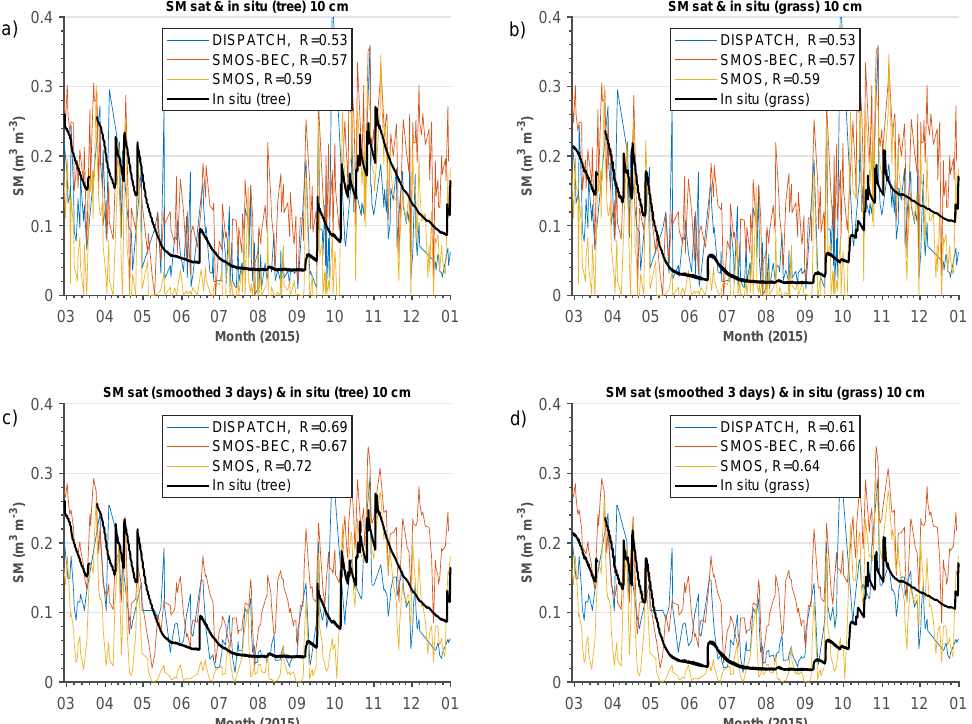
Figure 6. Comparison of soil moisture (SM) provided by DISPATCH (blue), SMOS-BEC (red), and SMOS (yellow) and 10-cm in situ measurements (black line), using measurements beneath the trees ( a , c ) and in the grass ( b , d ). Results with original data ( a , b ) and applying a low-pass filter of 3 days ( c , d ). Correlations between the SBSM products and the in situ measurements are indicated in the